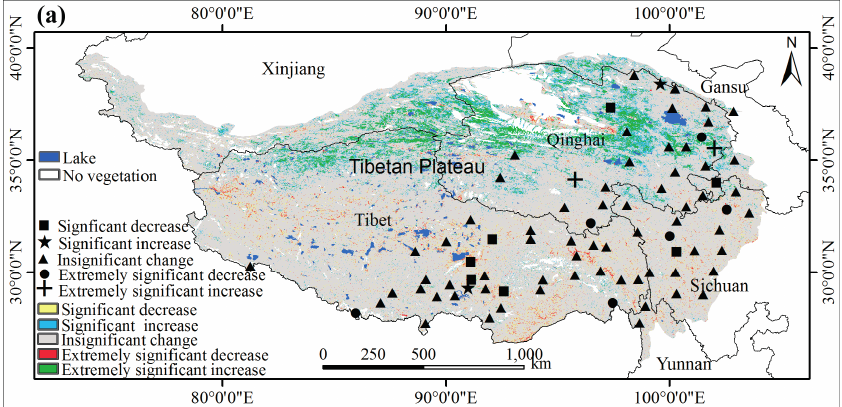
Figure 5. Growing season maximum enhanced vegetation index trends from 2000 to 2012 at 81 meteorological stations on the Tibetan Plateau; ( a ) significance test; and ( b ) regression